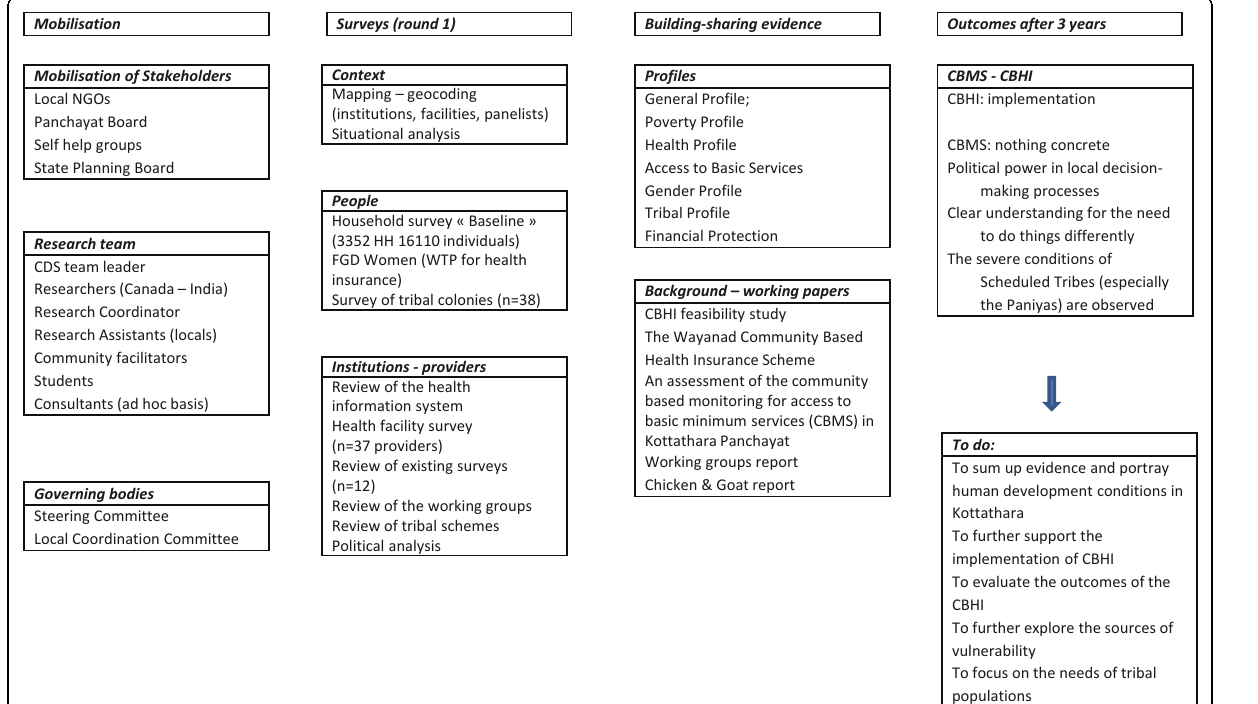
Figure 1 Phase I activities (2002-2005) . Phase I activities included: 1) mobilizing partners by holding individual and community-wide meetings; 2) implementing surveys; 3) analyzing data, preparing detailed but easy to read statistical profiles of Kottathara, and presenting findings to the community and scientific audience; and 4) designing the